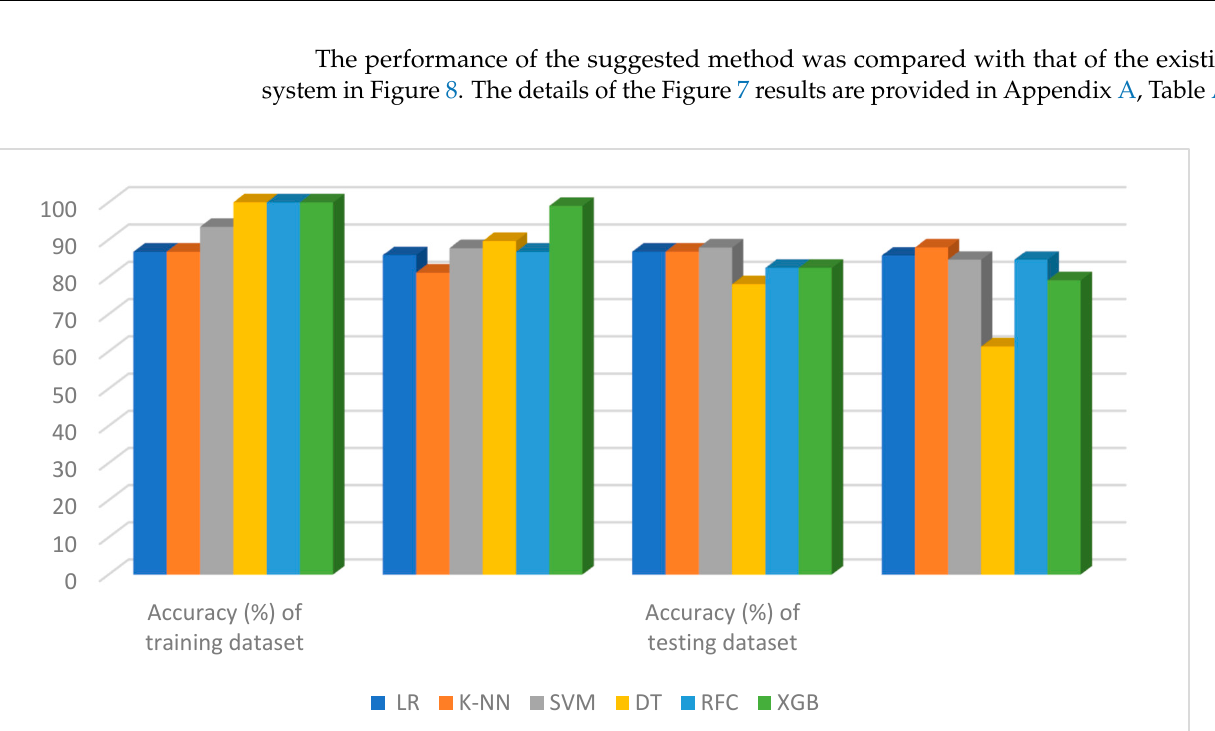
Table 8. For both the training and testing datasets, classification models were evaluated and compared after using dataset-II.